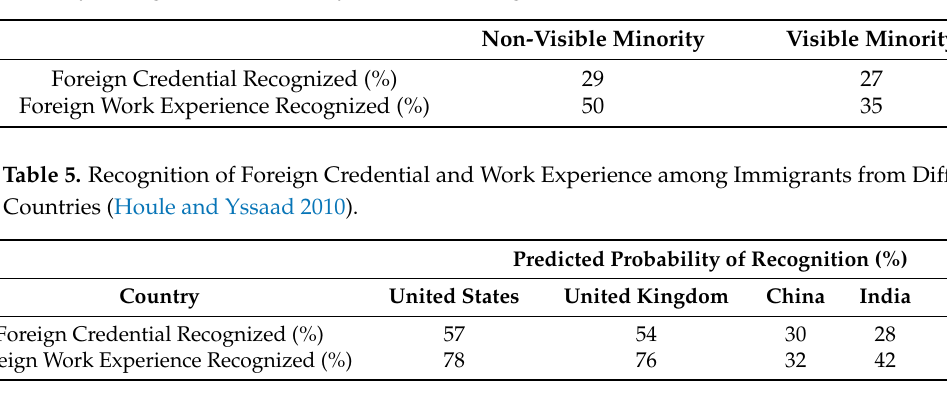
Table 4. Recognition of Foreign Credential and Work Experience among Visible and non-Visible Minority Immigrants within four years after landing in Canada (Houle and Yssaad 2010).